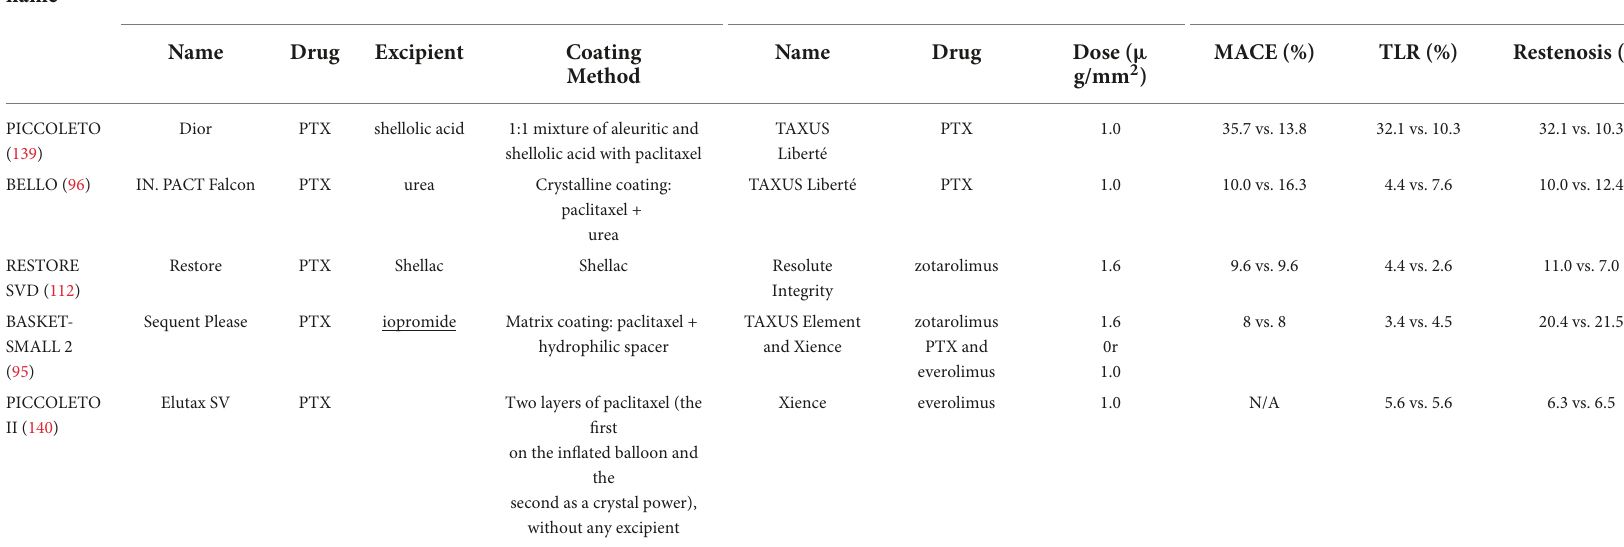
TABLE 3 Randomized, controlled trials of the efficiency of DCBs for the treatment of small vessel de novo coronary artery